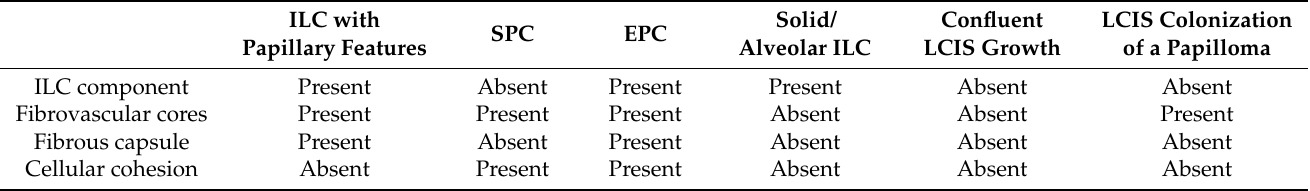
Table 6. A summary of the most important distinguishing features of ILC with papillary pattern and its histological